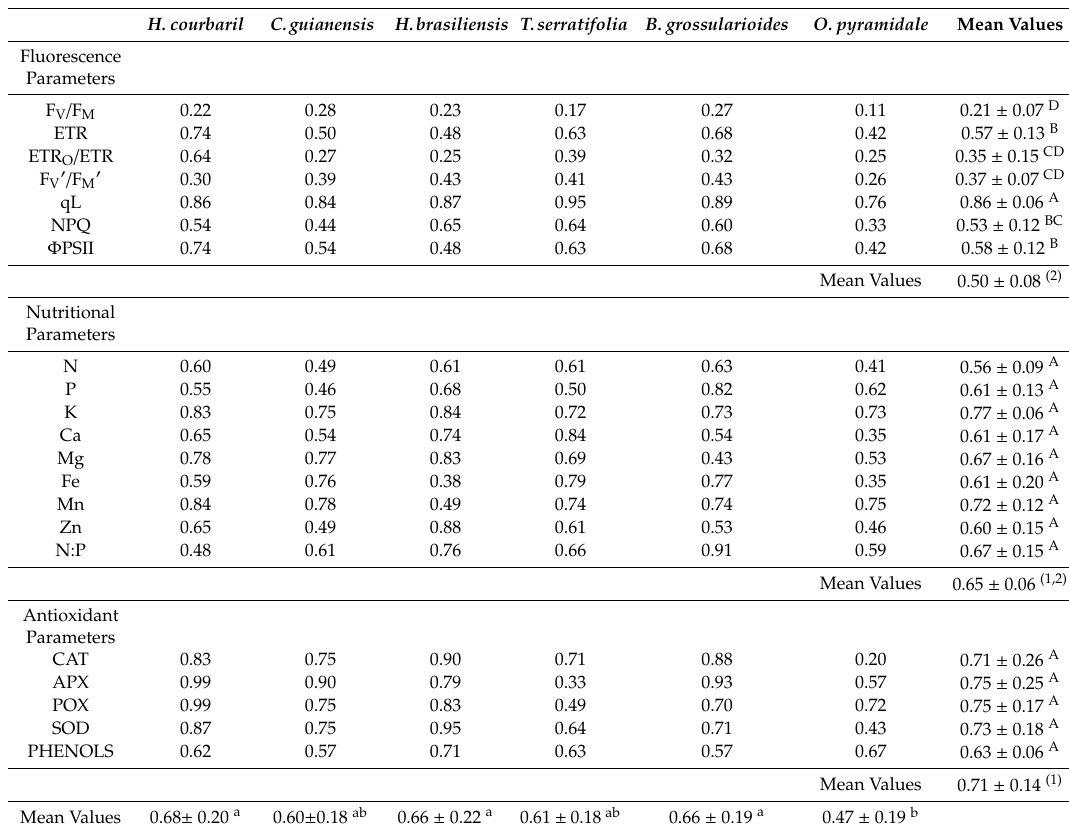
Table 4. Plasticity index of fluorescence, nutritional, and antioxidant parameters of six tree species submitted to three light